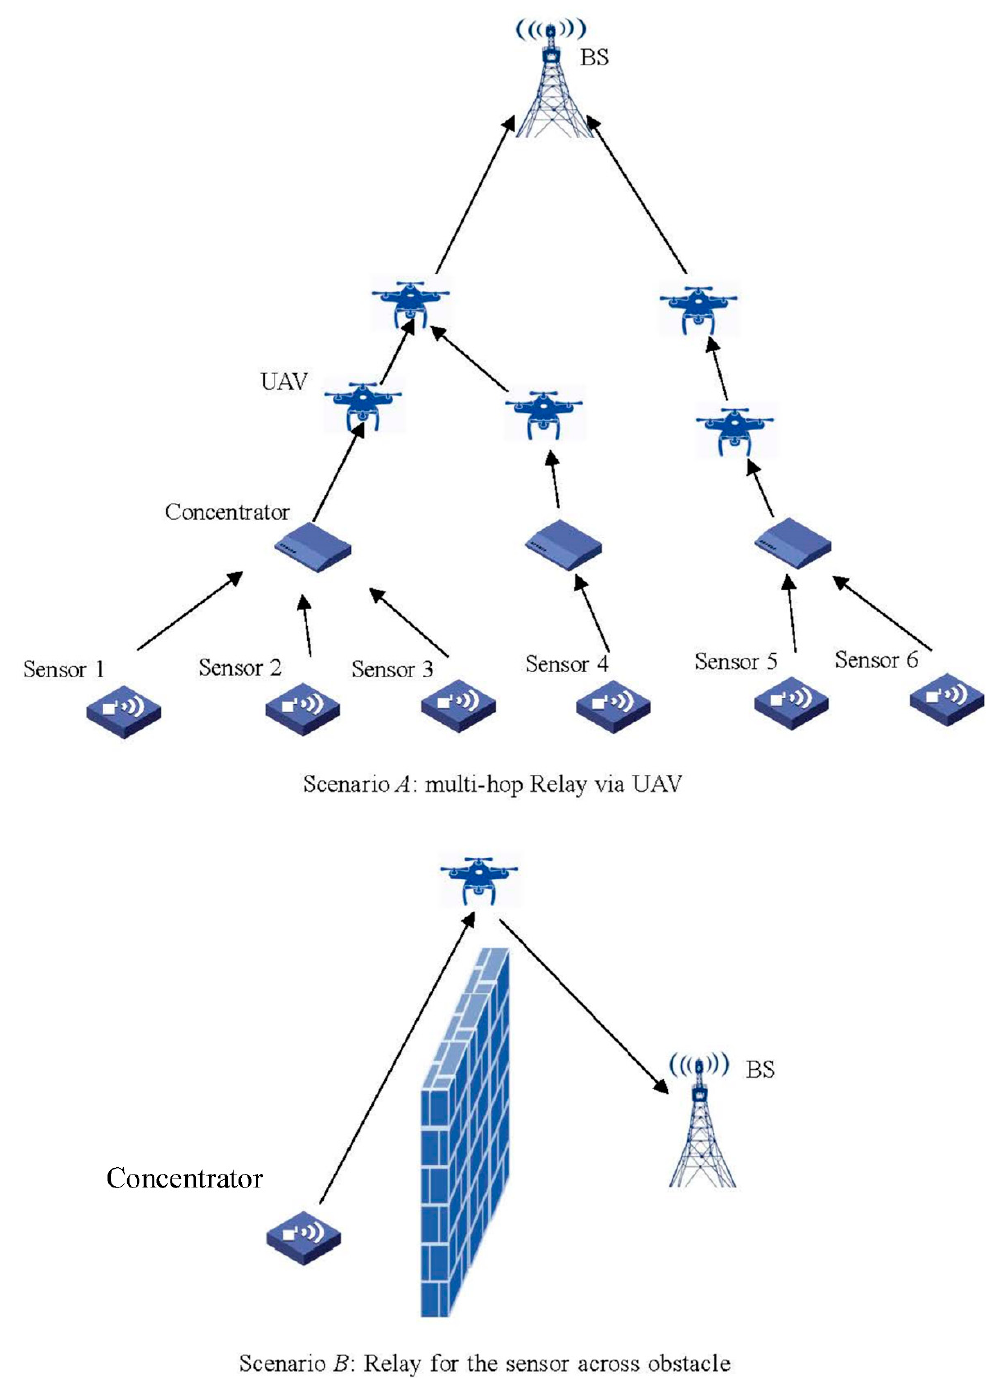
Figure 7. Scenarios of UAV based relay in WSN.